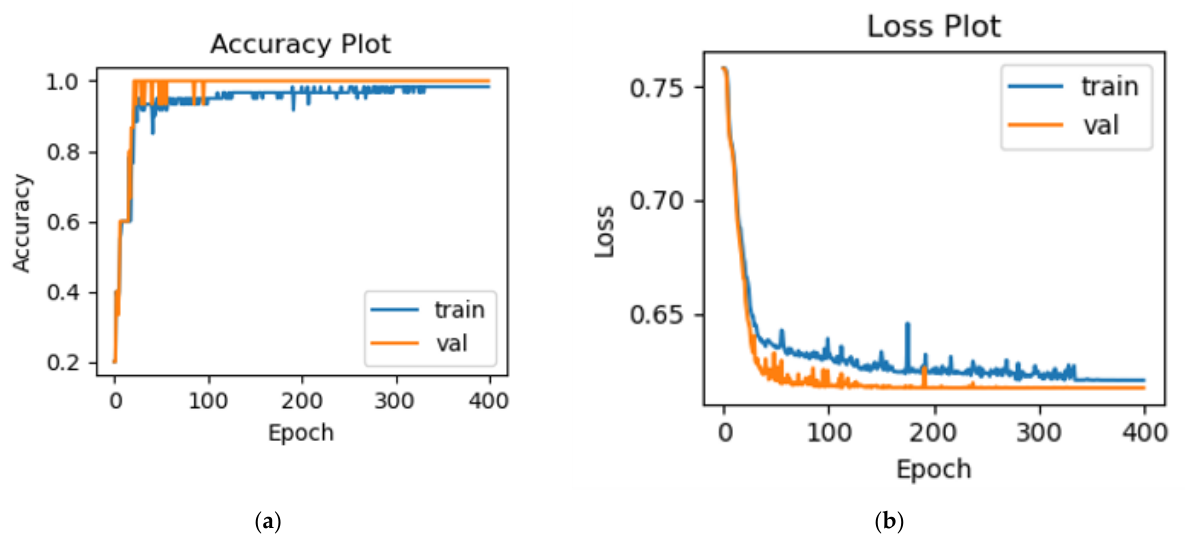
Figure 6. The training results of 1D-CNN for classification of 5 types of fruits: ( a ) the accuracy plot and ( b ) the loss plot.